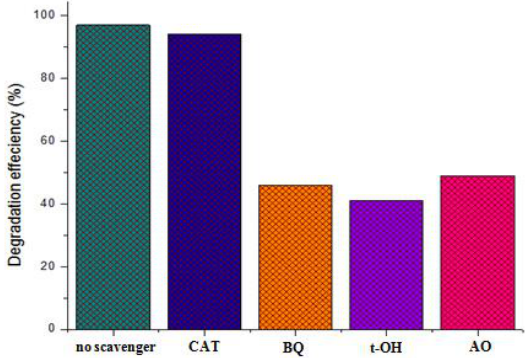
Fig. 10. Effect of scavengers on the photocatalytic activity of CuO/CeO